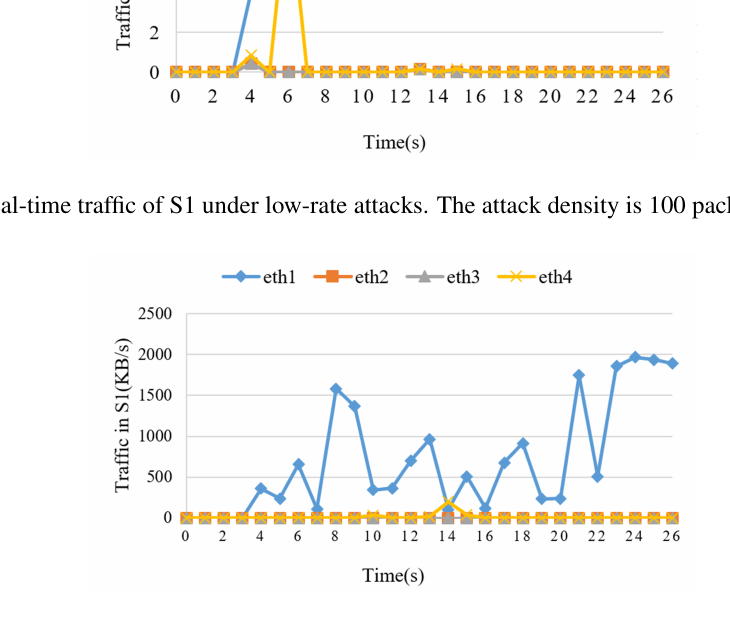
Fig. 8 Real-time traffic of S1 under high-rate attacks. The attack density is 106 packets per